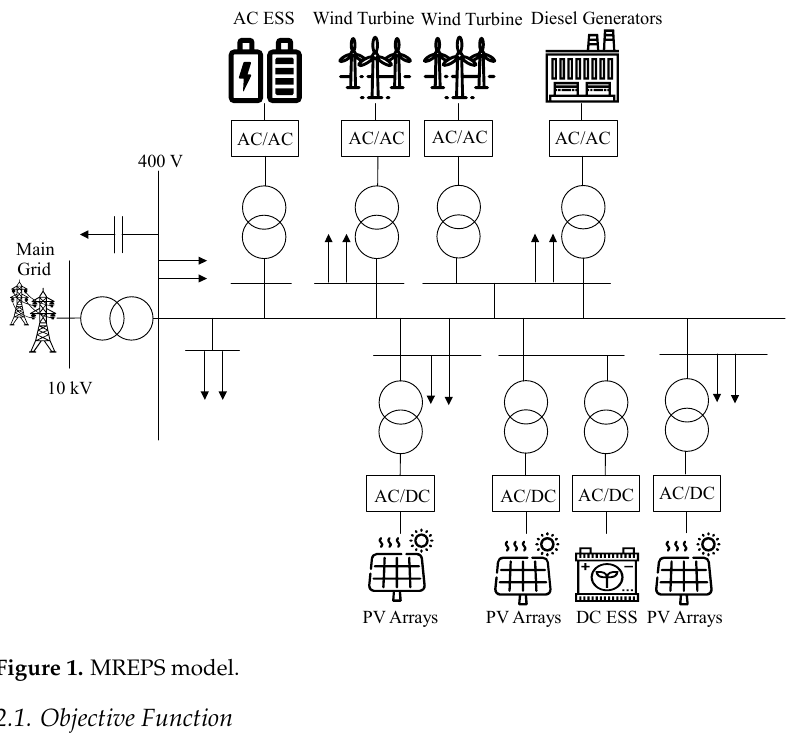
Figure 1. MREPS model.